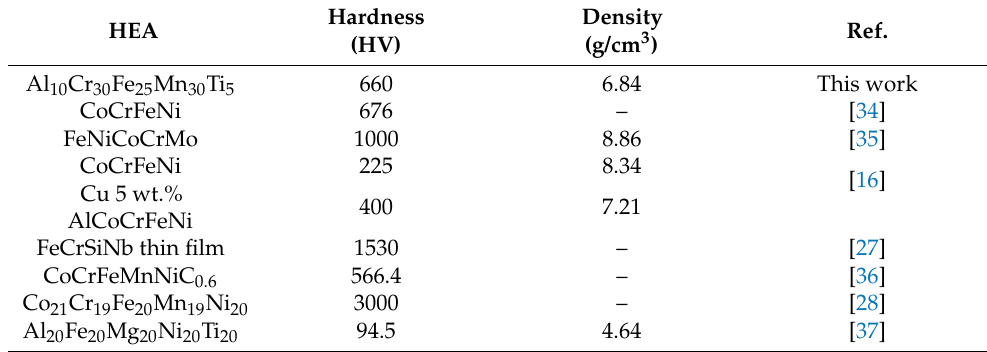
Table 6. Hardness and density properties comparison between